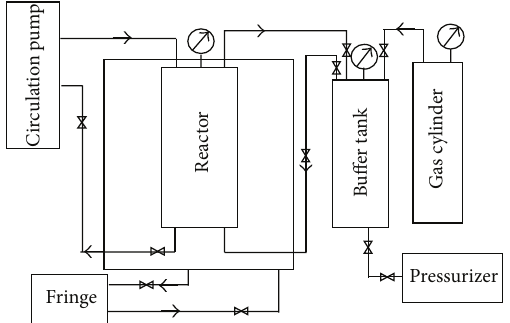
Figure 1: Experiment flow of hydrate formation.